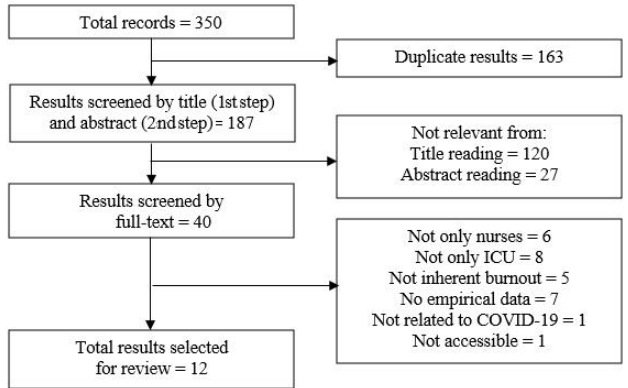
Figure 1 . Process and results of the search strategy deployed in the current study. Figure 1. Process and results of the search strategy deployed in the current